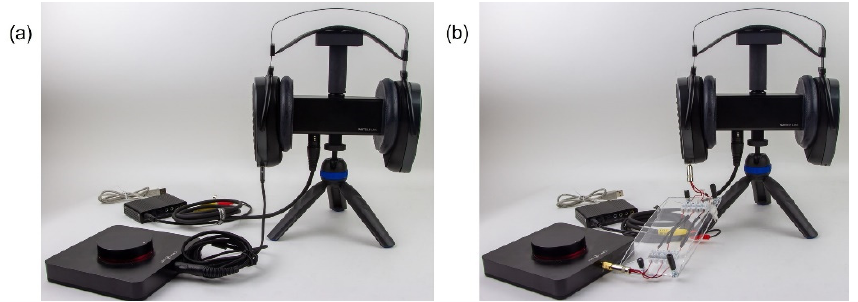
Figure 5. ( a ) Control setup for the frequency response measurement of the HiFiMAN Arya head- phones using commercial copper headphone and microphone cables and ( b ) the setup using the CNT/Cu audio cable as the headphone cable along with the same commercial microphone cable.